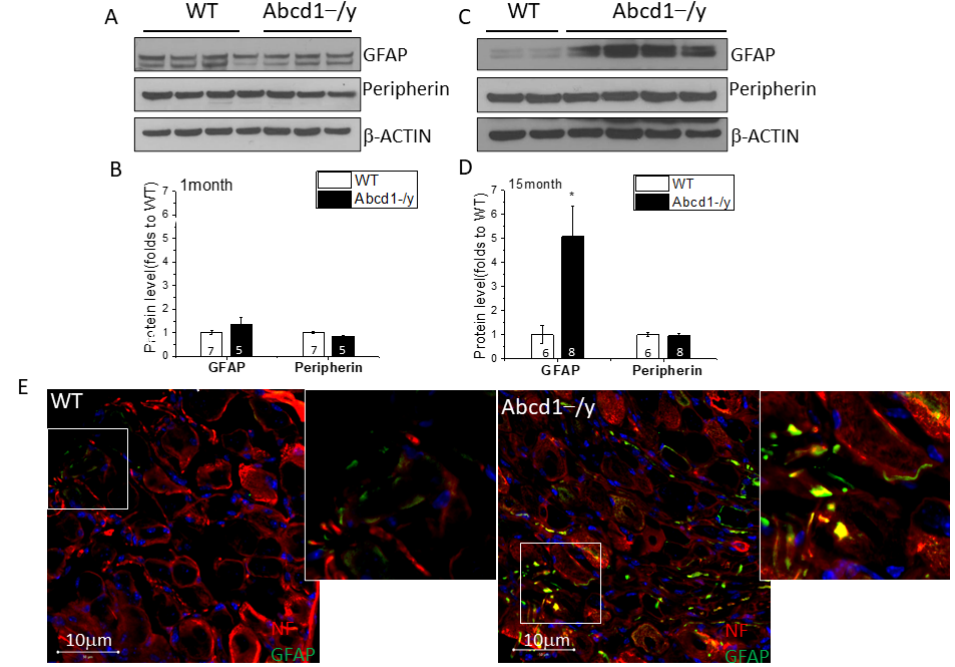
Figure 6. Increased GFAP expression occurs early in Abcd1 − /y mouse DRG. ( A ) Representative western blot images showing GFAP expression in 1-month-old mouse DRG tissue with peripherin as comparison. ( B ) Quantification of GFAP protein level in 1-month-old mouse DRG tissue with β − ACTIN as loading control (n = 7 for WT and n = 5 for Abcd1 − /y ). ( C ) Representative Western blot images showing GFAP expression in 15-month-old mouse DRG tissue with peripherin as comparison. ( D ) Quantification of GFAP protein level in 15-month-old mouse DRG tissue with β − ACTIN as loading control (n = 6 for WT and n = 8 for Abcd1 − /y ). ( E ) Representative confocal images showing increased GFAP staining (green) in 15-month-old Abcd1 − /y mouse DRG. Results were expressed as means ±SEM.* p < 0.05 as compared with WT control.